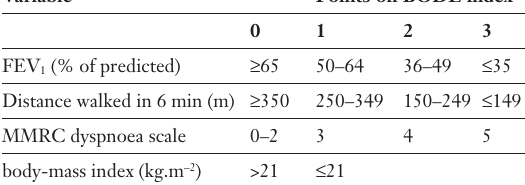
Variables and point values used for assessing the BODE index (adapted from reference